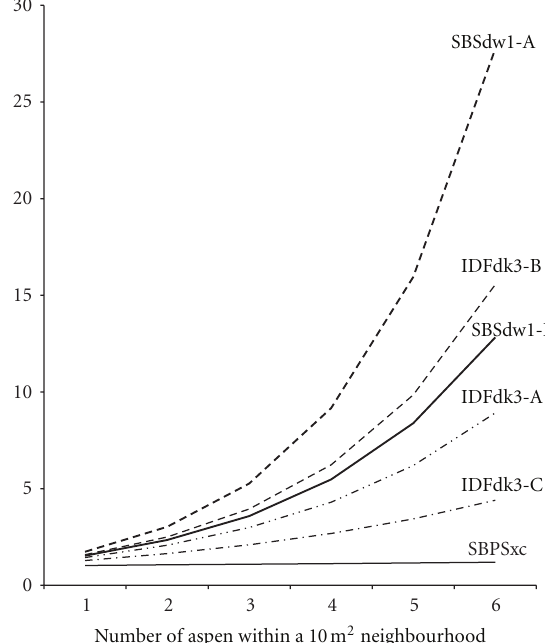
Figure 5: Increase in risk of unacceptable pine vigour at age 17–20 with increasing density of aspen stems having HR ≥ 1.5 (assessed within a 10m 2 subplot) at age